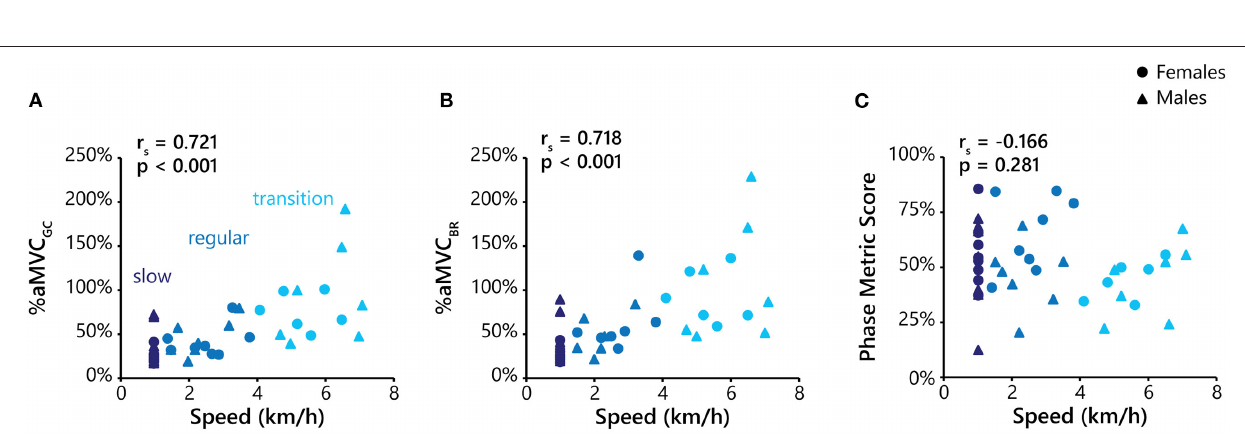
FIGURE 5 | Plots of %aMVC GC (A) , and %aMVC BR (B) , and phase metric score (C) against treadmill speed. For each plot, data is presented from the slow walking (dark blue), regular walking (medium blue), and transition walking (light blue) conditions. Data from female participants are represented as circles, and males as triangles. The alpha value ( p ) and Spearman’s correlational coefficient (rho; r s ) are displayed in the upper left-hand corner of each plot. Only the walking conditions were included in this analysis to control for gait